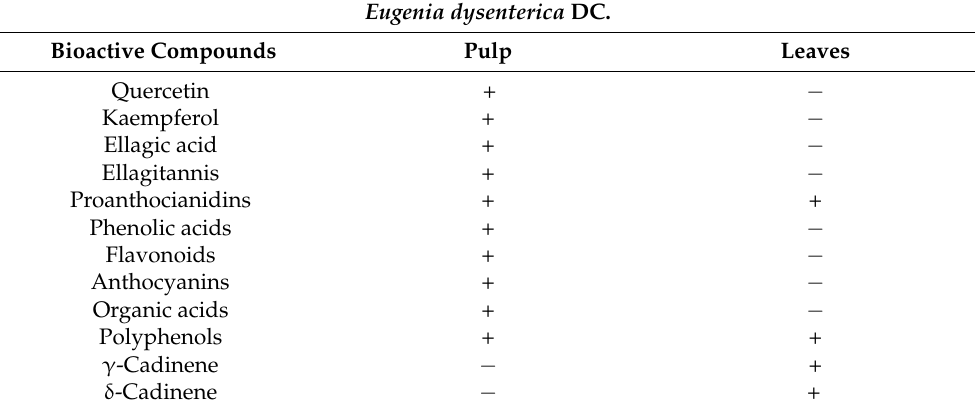
Table 3. Bioactive compounds in E. dysenterica DC. [25–30].